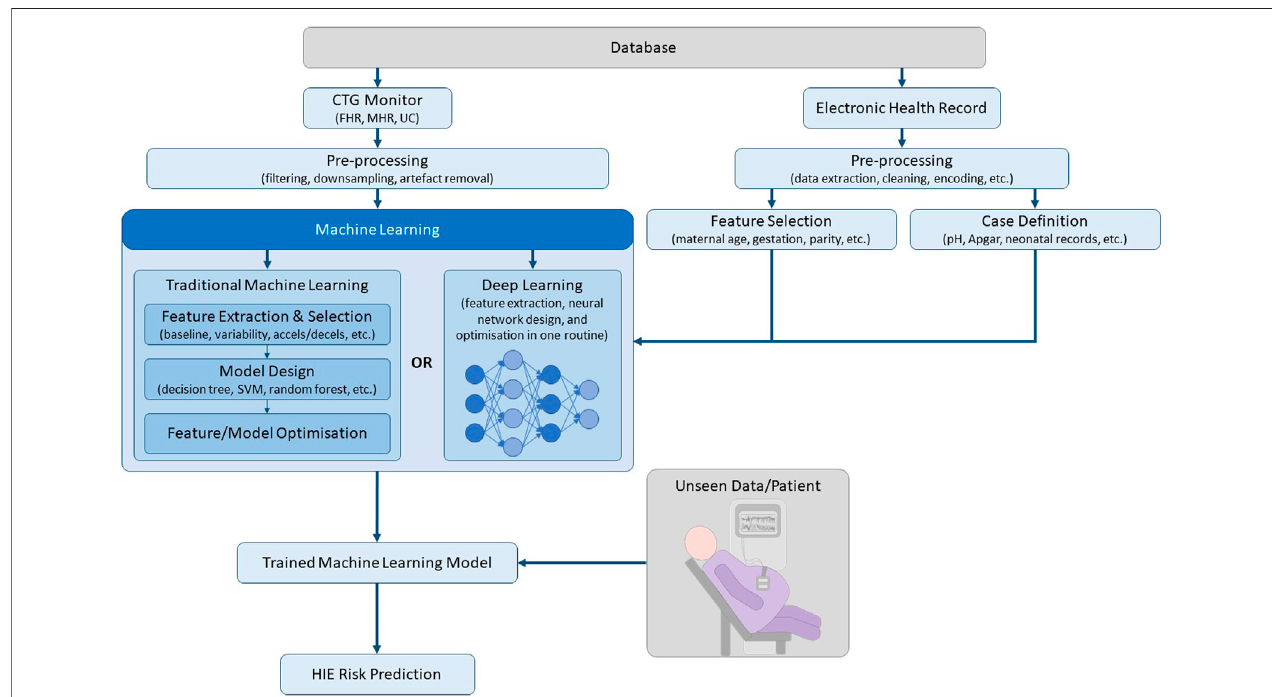
FIGURE 1 | Pipeline of machine learning steps for